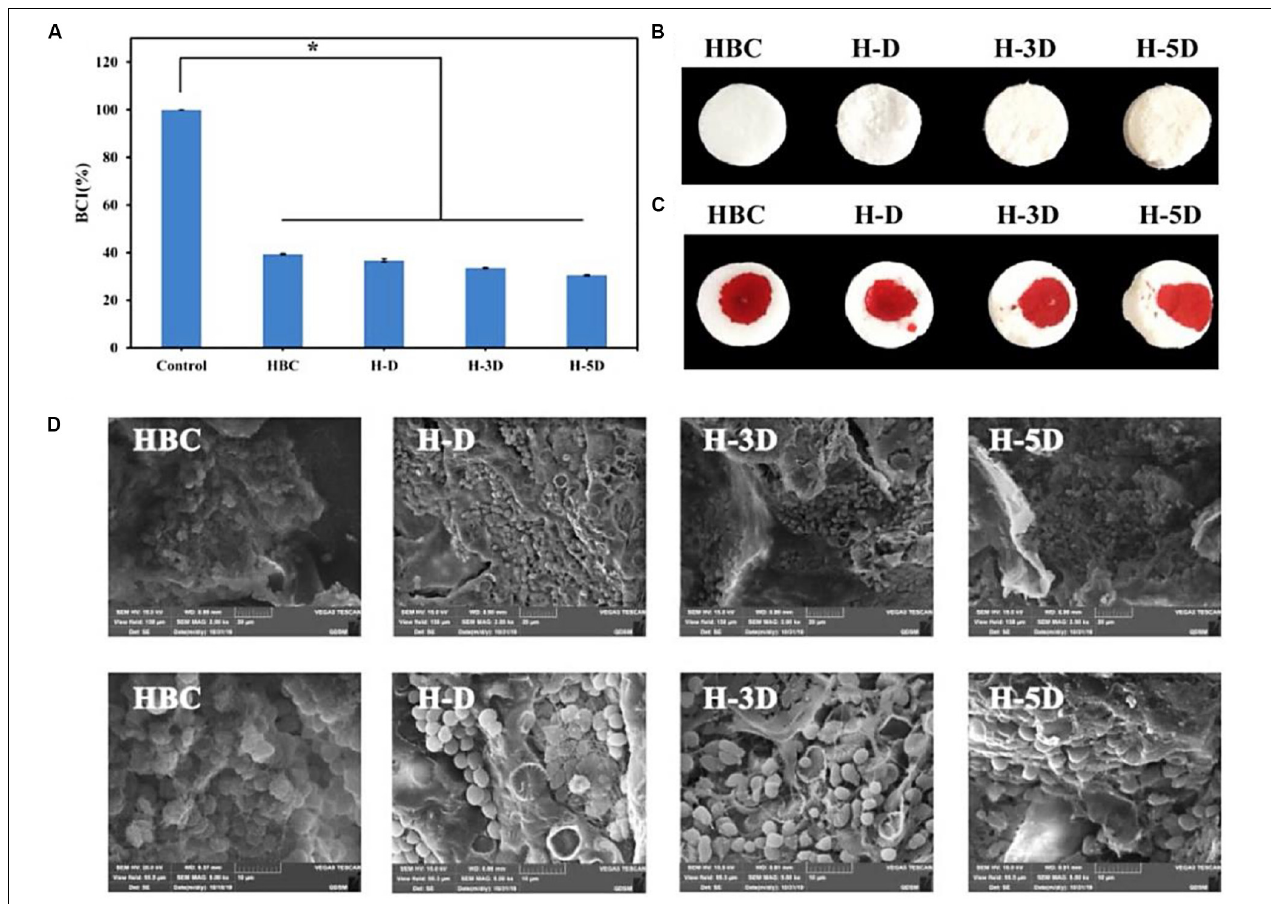
FIGURE 7 | (A) BCI ration of HBC, H-D, H-3D, and H-5D. The data represent mean ± SD ( n = 3), p < 0.05. The photo of composite sponges (B) without and (C) with blood. (D) SEM of red blood cell aggregation on HBC and H-Ds. Reproduced from Zhang et al. (2020) with permission from Copyright 2020